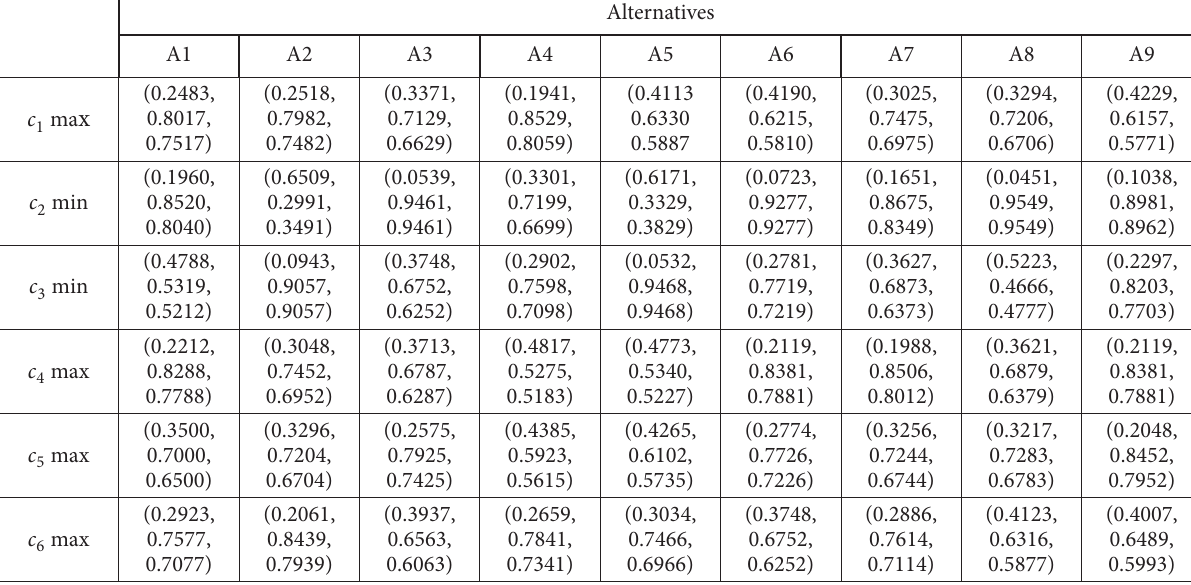
Table 7. The aggregated decision